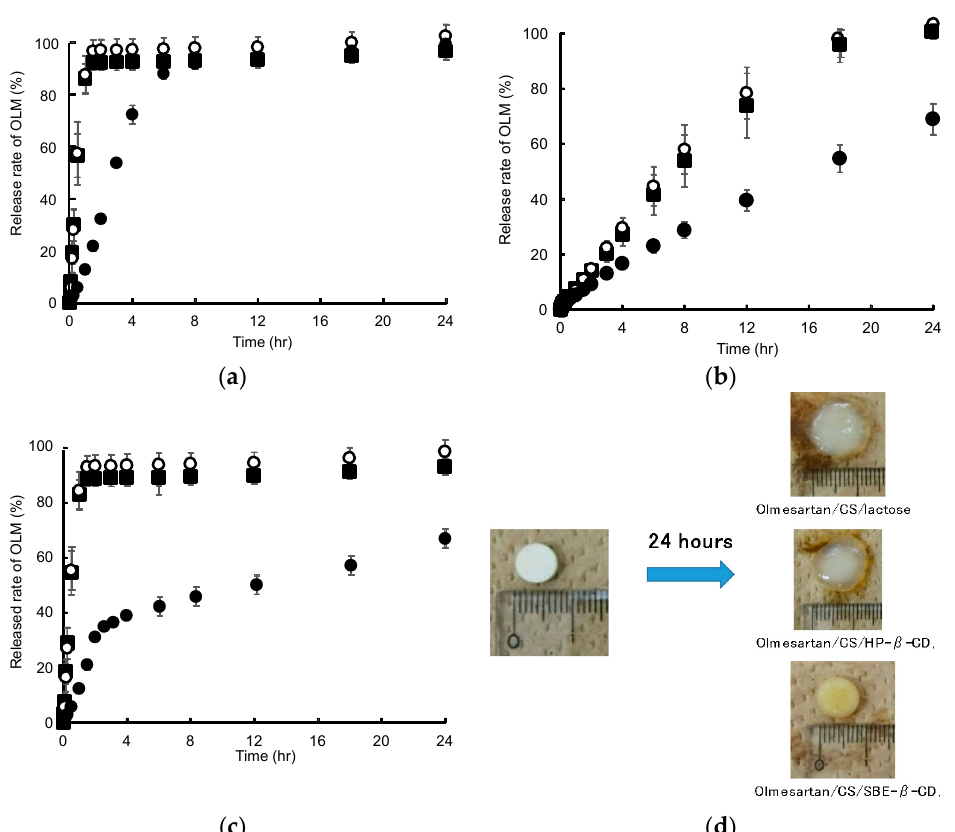
Figure 4. Release profiles for olmesartan tablets (OLM) from tablets at pH 1.2 ( a ), pH 6.8 ( b ), sequential exposure to pH 1.2 and pH 6.8 ( c ) and microscopic observation of OLM/SD-CS/lactose, OLM/SD-CS/HP- β -CD, and OLM/SD-CS/SBE- β -CD tablets before (left) and after 24 h (right) in media at pH 6.8 ( d ). OLM/ SD-CS/SBE- β -CD (close circle), OLM/SD-CS/HP- β -CD (open circle), and OLM/SD-CS/lactose (close square). (SD-CS = spray-dried chitosan, SBE- β -CD = sulfobutyl ether- β -cyclodextrin).